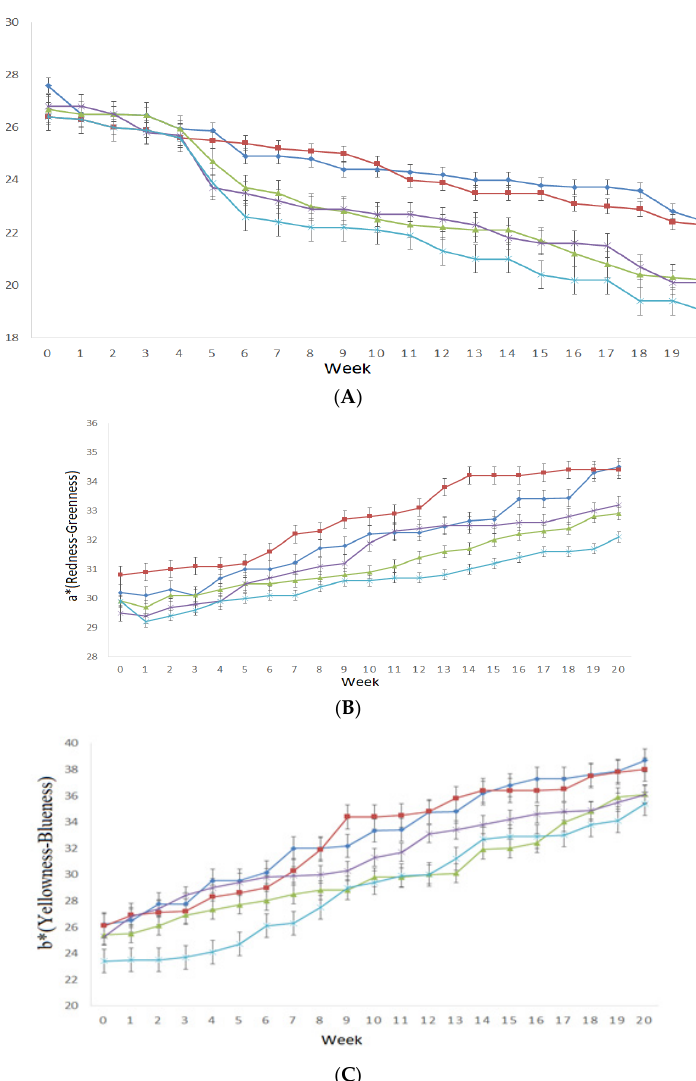
Figure 4. Instrumental color CIELAB parameters L* ( A ), a* ( B ), and b* ( C ) of hot sauces prepared with tequila (dark blue line), bourbon (green line), vodka (purple line), rum (light blue line), and control (brown line) during 20 weeks of storage under accelerated conditions.